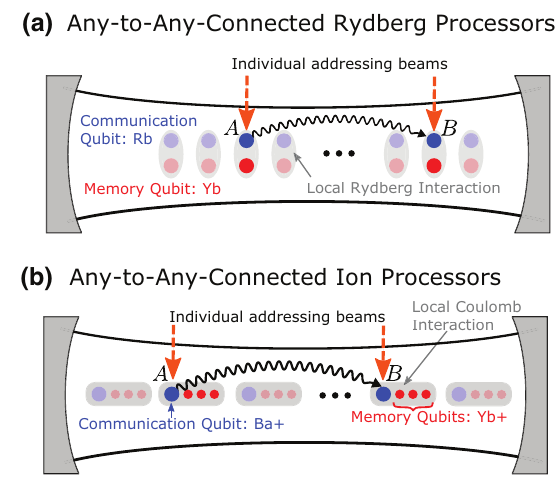
FIG. 1. Architecture for cavity-mediated quantum gate between any two qubits applied to (a) Rydberg atoms or (b) multiple chains of trapped ions. Photon transfers via the cavity produce heralded entanglement of communication